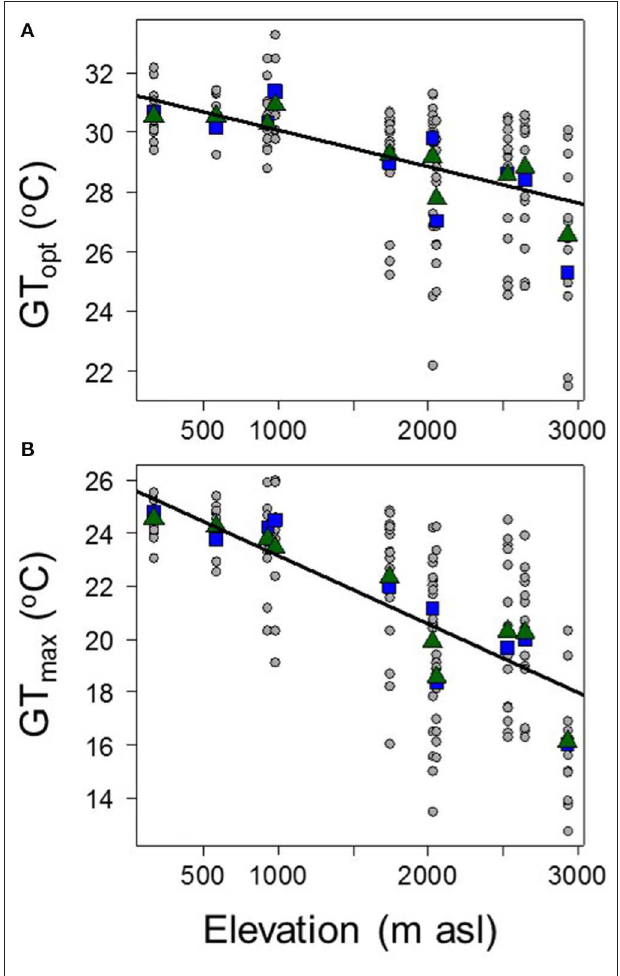
FIGURE 3 | The relationships between plot elevation and species’ (A) geographic-based thermal optima (Gt opt ), and (B) geographic-based thermal maximum (GT max ). Circle points and lines show species-level data; square points show plot-level averages with the species weighted by their relative abundances, and triangle points show unweighted plot averages. GT opt = 25.72 ◦ -0.0026 × Elevation, R 2 = 0.45, P < 2e − 16 ; GT max = 31.29 ◦ -0.0012 × Elevation, R 2 = 0.2, P = 1.07 e − 10 .